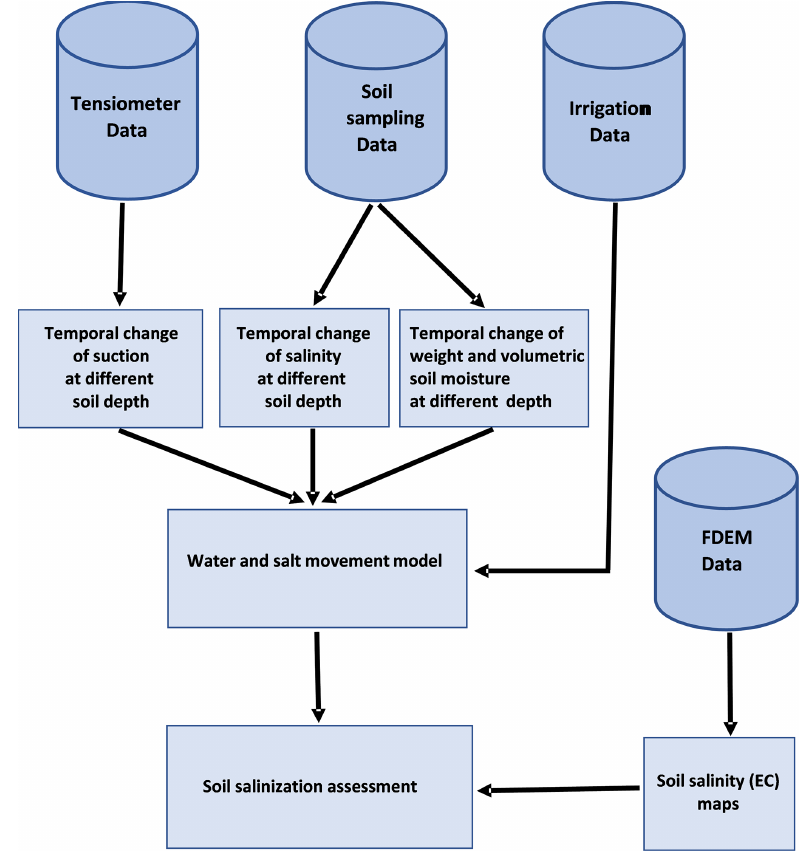
Figure 4. The conceptual working process applied to soil salinization assessment.